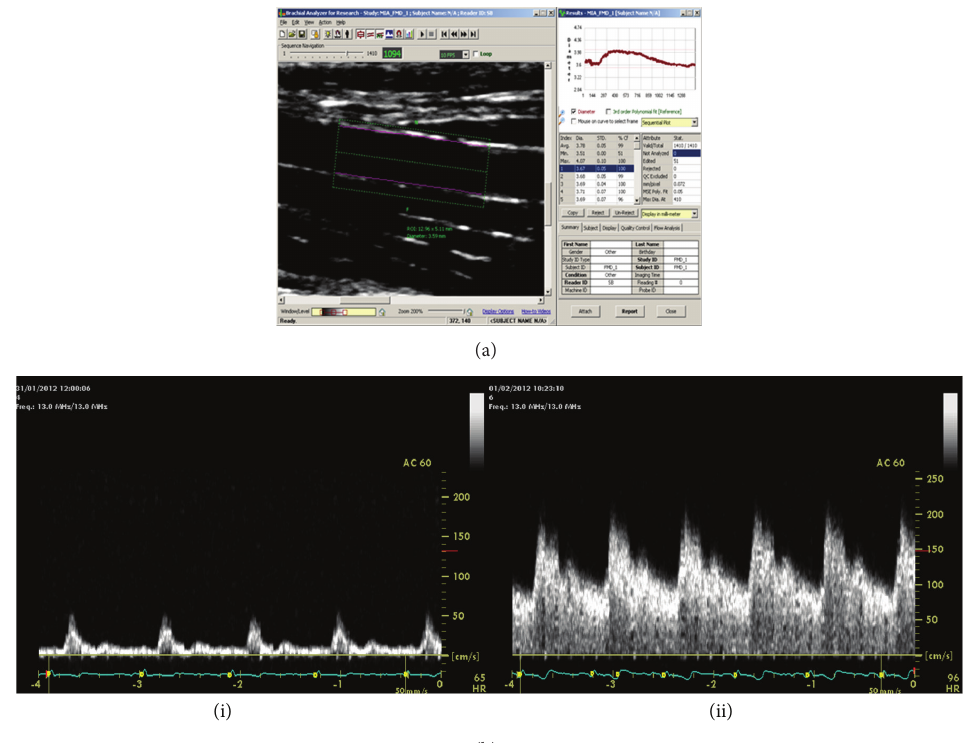
Figure 2: (a) Image of a longitudinal view of a brachial artery analyzed by customized edge detection software producing diameter measurements. (b) Velocity data for the brachial artery at (i) rest and (ii) hyperemia on cuff